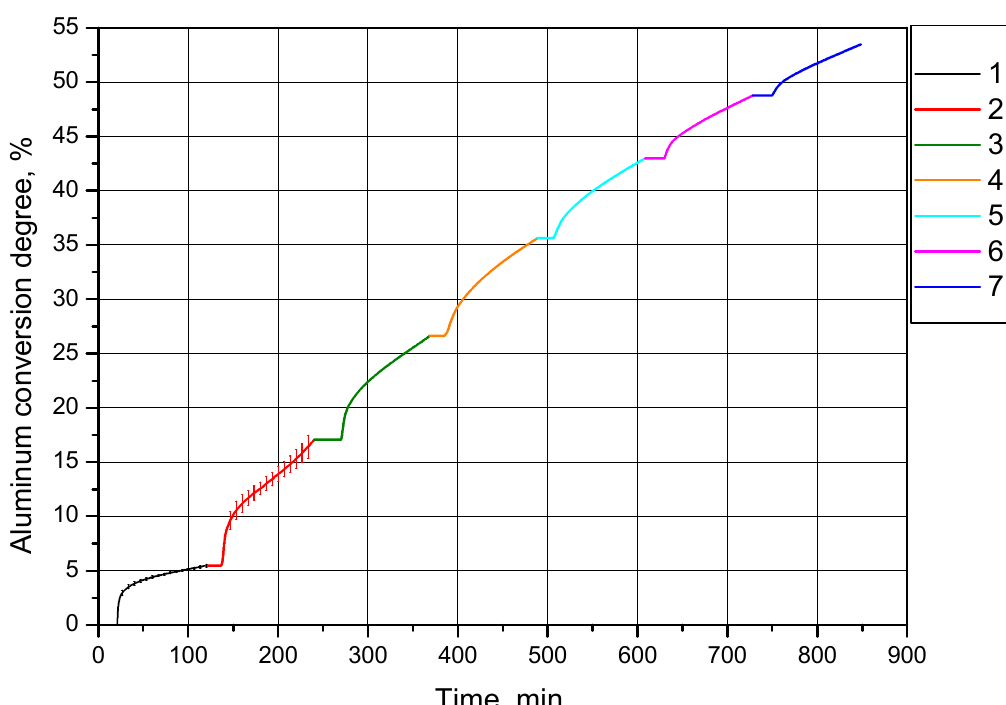
Figure 9. Aluminum conversion degrees (hydrogen yields) for the powder sample subjected to alternating oxidation and thermal treatment at 500 °C (with preliminary drying at 120 °C): 1—original aluminum powder, 2—sample after the first thermal treatment, 3—sample after the second thermal treatment, 4—sample after the third thermal treatment, 5—sample after the fourth thermal treatment, 6—sample after the fifth thermal treatment, 7—sample after the sixth thermal treatment. Table 3. Aluminum conversion degrees (hydrogen yield) for the powder sample subjected to alternating oxidation and thermal treatment at 500 °C (with preliminary drying at 120 °C). Sample Original aluminum powder Sample after the first thermal